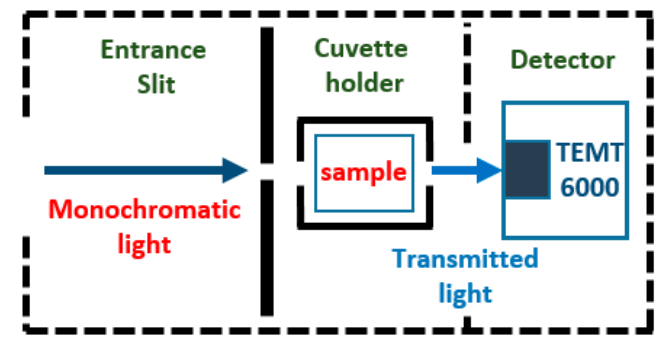
Figure 3. Details of the detector stage.